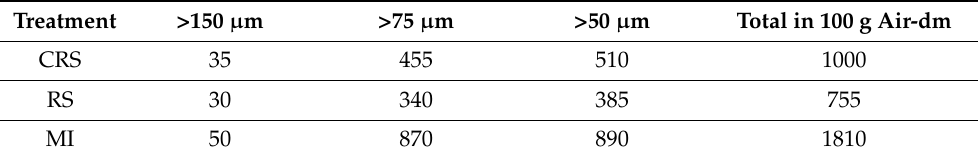
Table 1. The number of spores of endomycorrhizal fungi in the replant soil (CRS = crop rotation soil, RS = replanted soil, MI = micorrhyzal inoculum).